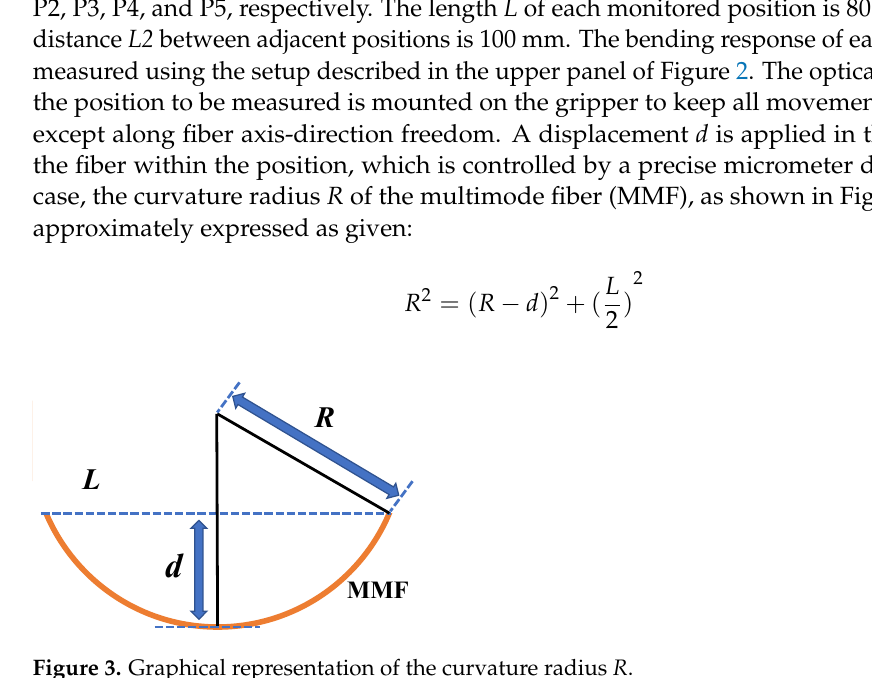
Figure 2. Experimental setup of the proposed fiber specklegram bending sensing system. CCD, charge-coupled device camera; OBJ, objective; MMF, multimode fiber; P, bending position.